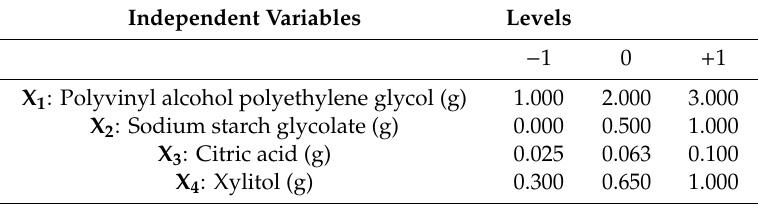
Table 4. Independent variables employed for the Box Behnken design template.